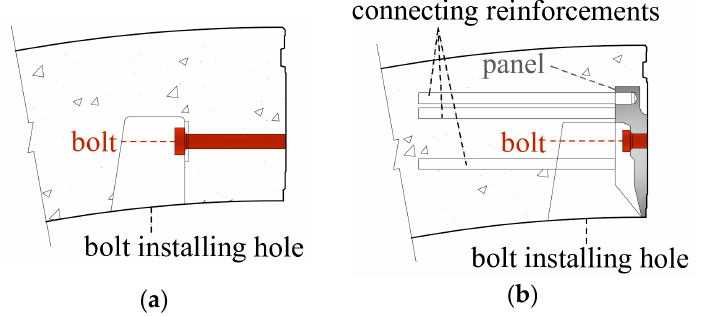
Figure 1. Two types of longitudinal joints for concrete segments connected by bolts: ( a ) joint without panels; ( b ) joint with panels.